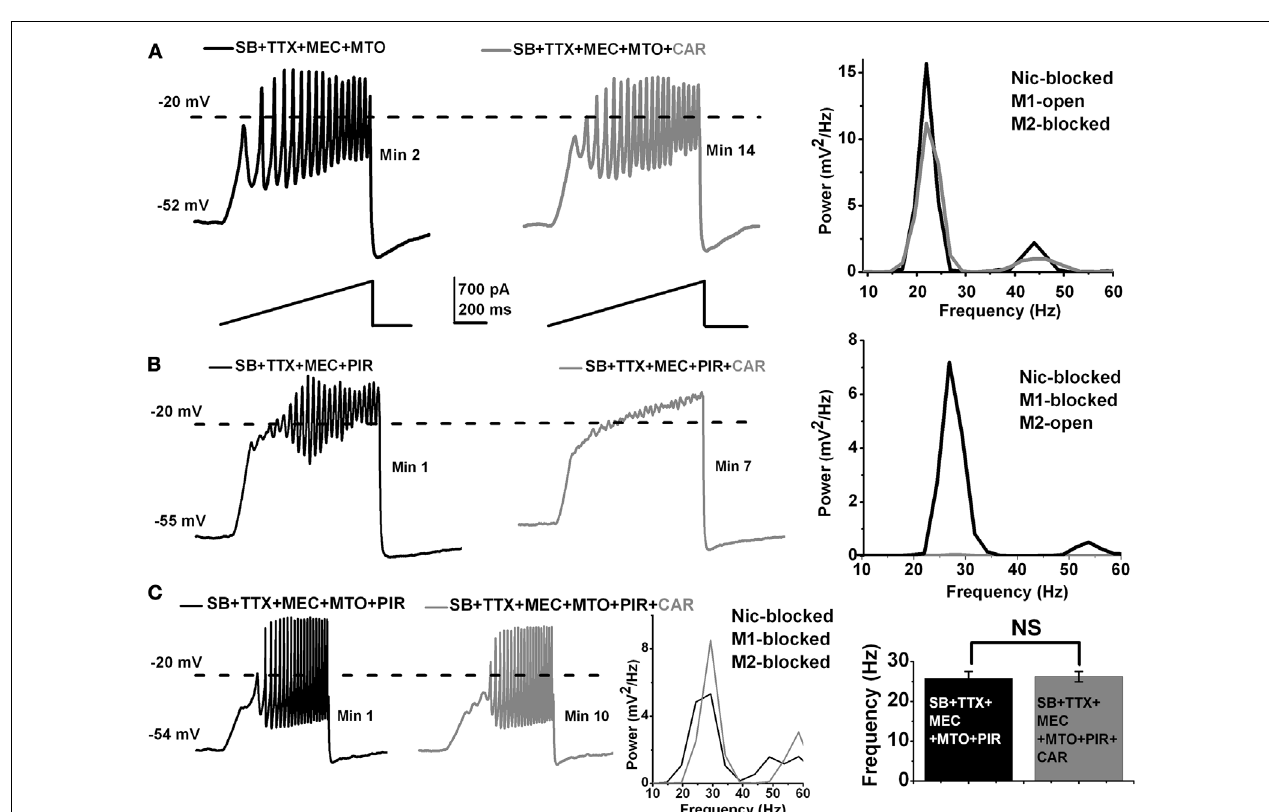
through M2 muscarinic receptors. (C) Representative membrane oscillations recorded during 1s long ramps in the presence of SB + TTX and all the cholinergic blockers MEC + MTO + PIR (left record, black). Addition of CAR to the extracellular solution had no effect on the oscillations (left record, gray). The power spectrum of these records shows no shift in frequency after exposure to CAR (middle).The bar graph (right side) shows the mean frequency of oscillations before and after acute exposure to CAR in the presence of SB + TTX + MEC + MTO + PIR. Note that there was no statistical difference in the mean of frequency before (black column, n = 4) vs. after (gray column, n = 4) addition of CAR to the extracellular solution in the presence of nicotinic and muscarinic blockers. (Abbreviations: CAR, carbachol; SB, synaptic blockers;TTX, tetrodotoxin; MEC, mecamylamine; MTO, methoctramine; PIR,